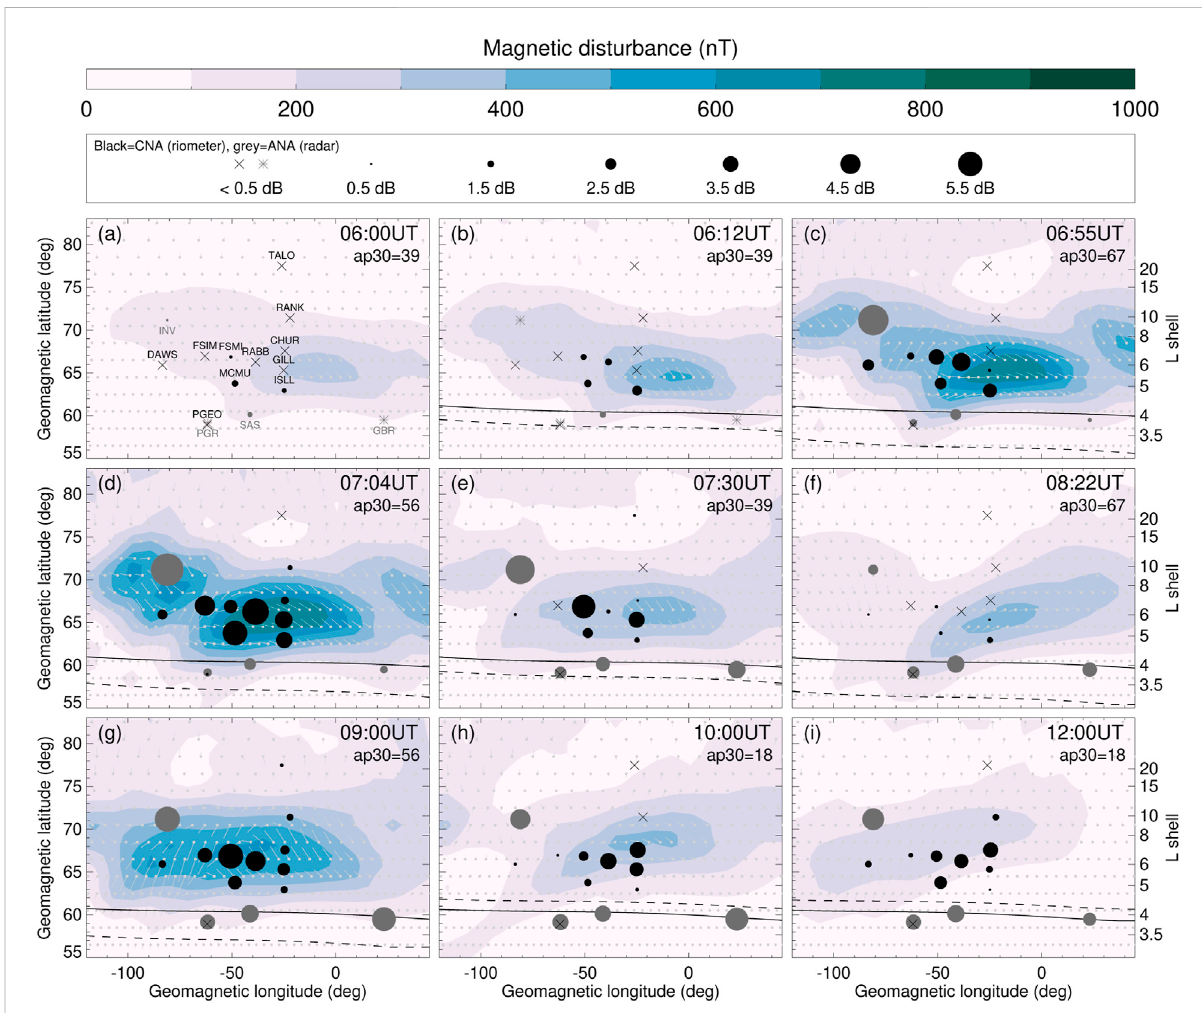
FIGURE 7 Spatial evolution ofthemagnetic fi eld disturbance,30 MHz cosmic noise absorption and 10 – 11 MHz atmosphericnoise attenuationduring the substorm on 25 October 2019. The solid black line near L = 4 indicates the lower-latitude boundary of > 30 keV electron fl ux from the van de Kamp et al. (2018) energetic electron precipitation model for Ap = 25, and the dashed line is the same boundary estimated from the ap30 index given in each panel (see text for